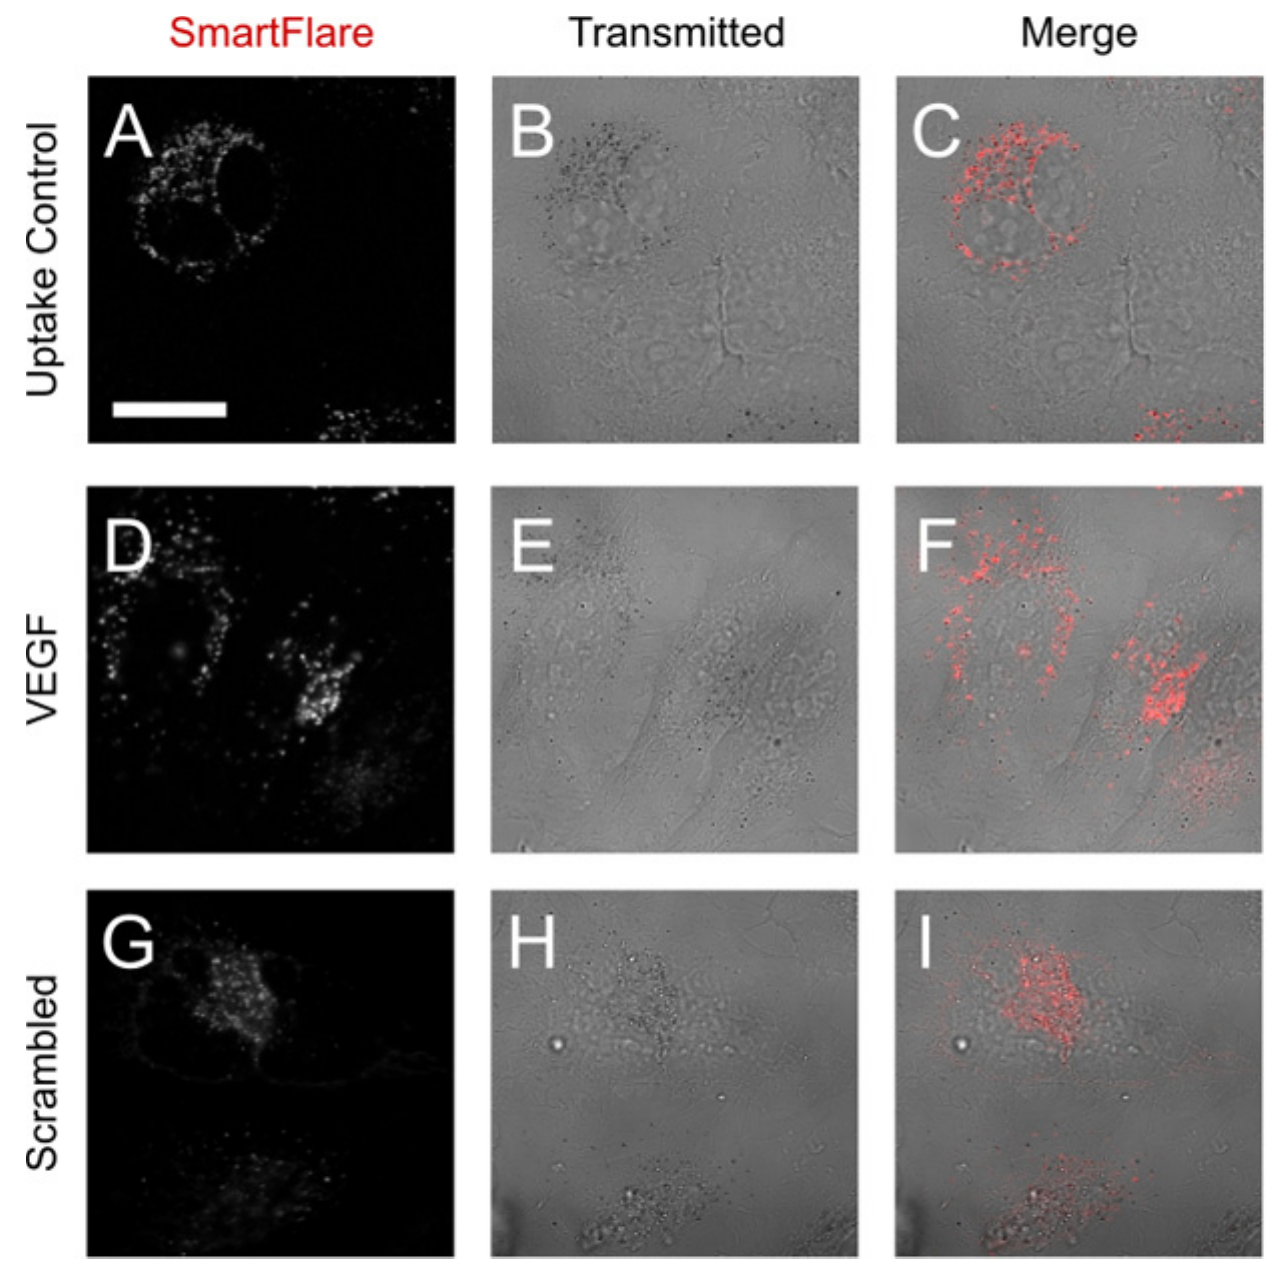
Figure 2. Cellular Uptake of SmartFlares : HeLa cells were exposed to Uptake Control (A – C), VEGF (D – E) or Scrambled Control (G – I) SmartFlares for 18 hours, then washed and imaged with confocal laser-scanning microscopy in fl uorescence (A,D,G) or transmitted (B,E,H) channels. An overlay of the two channels is shown in C,F and I. All frames are shown at identical magni fi cation, scale bar represents 10 μ